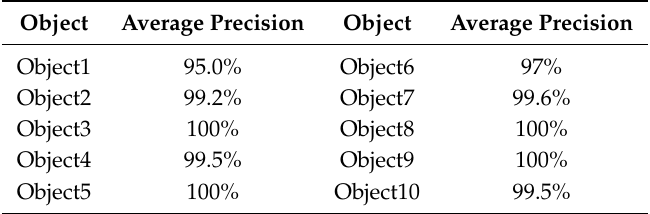
Table 1. Average precision of detecting object-of-interest on the testing images.